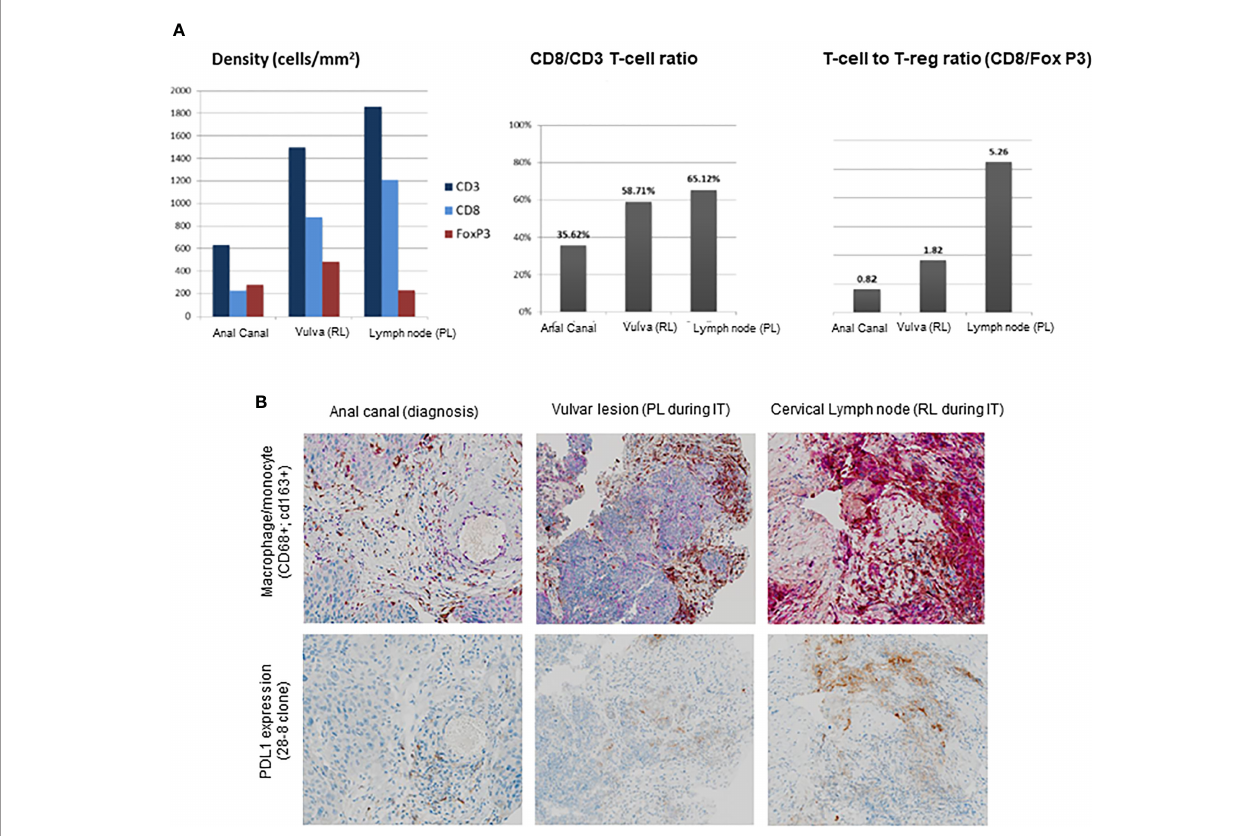
FIGURE 2 | (A) Population of T cells in anal canal (baseline), vulvar lesion (PL), and cervical lymph node (RL). (B) Macrophage/monocyte presence (A) and PD-L1 expression (B) were evaluated at diagnosis in the anal canal (primary tumor) and during treatment with anti-PD-1 agent in the vulvar lesion (progressive lesion) and in the cervical lymph node (responsive